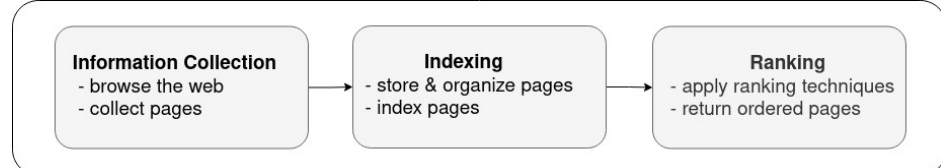
Figure 3. Keyword search engine process